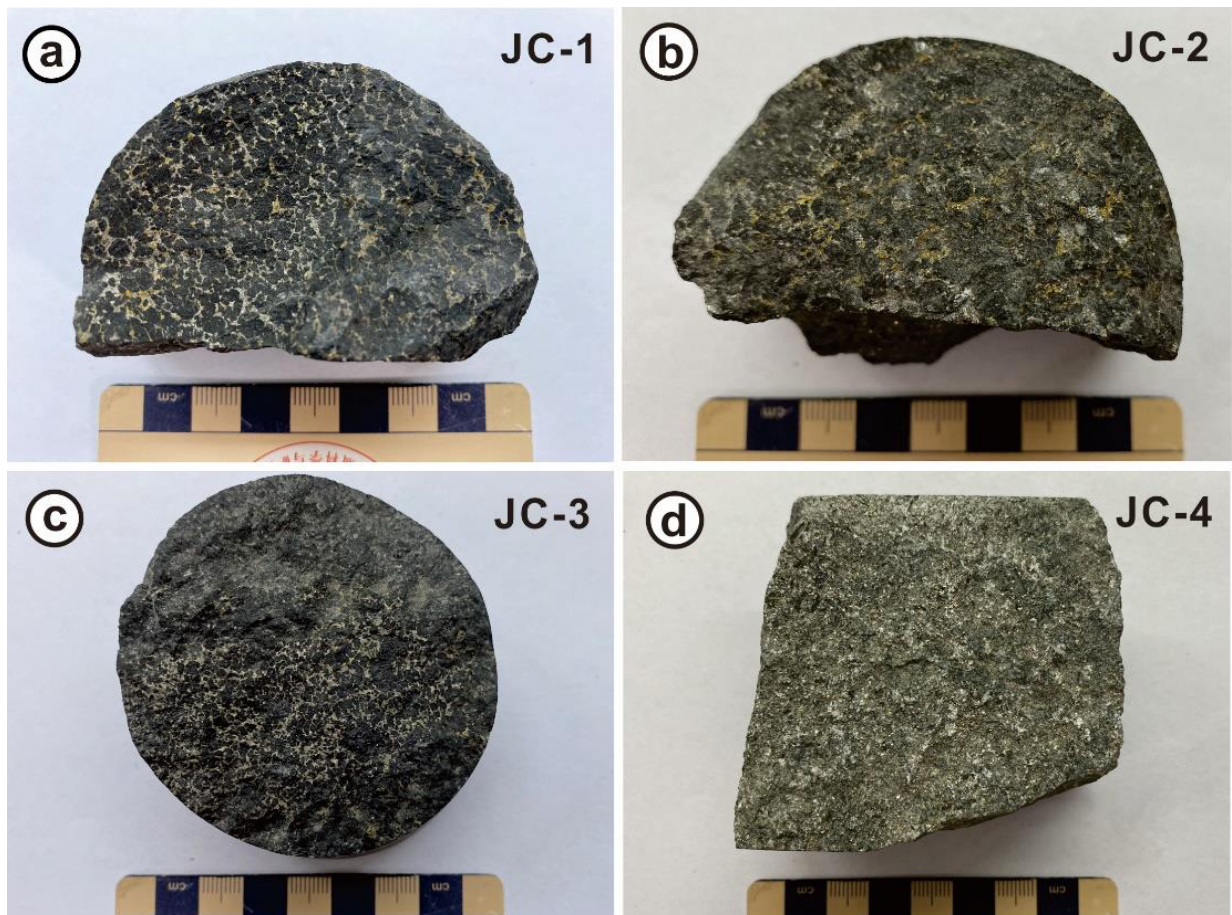
Figure 3. Photographs of the typical net-textured ( a – c ) and disseminated ( d ) sulfide ore samples from the Jinchuan Ni-Cu sulfide deposit. Samples JC-1, 2, and 3 are net-textured ores with sulfides filling the interstices between silicate mineral grains, sample JC-4 is a disseminated ore with sulfides sparsely dispersed between silicate mineral grains.